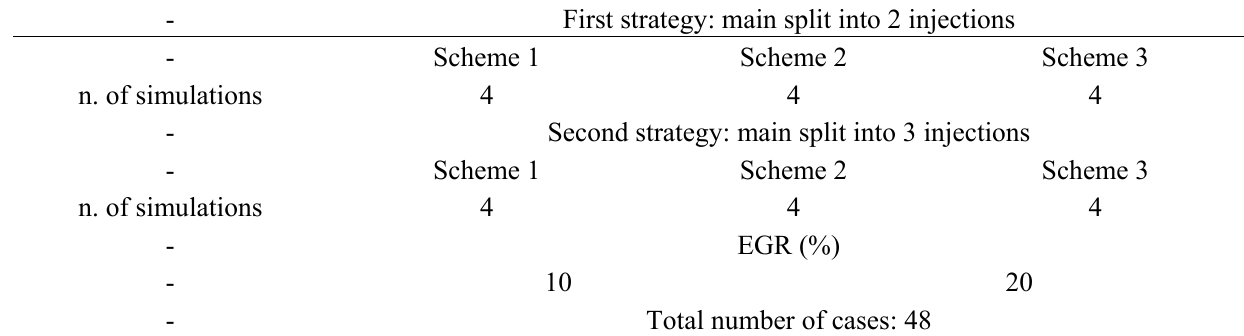
Table 4. Statement of